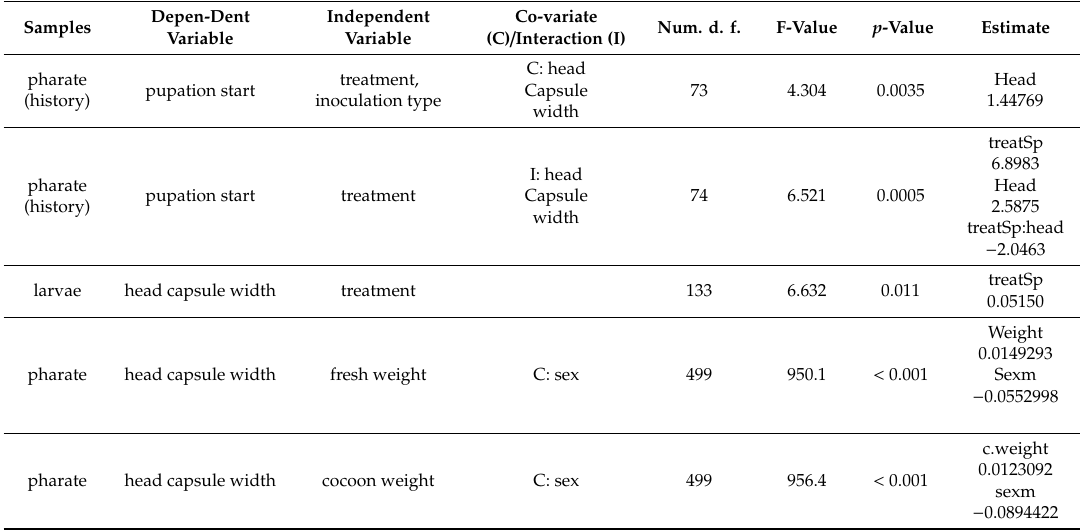
Table A5. Results of a linear multi factorial model exploring the e ff ect of treatment (Viable vs Sterile spores) on the pupation start, head capsule width and weight di ff erences during development and results of regressions of the three datasets for two development stages. Head capsule width, bee age or sex were used as covariates (C). lm = lineaer model, Estimate abbreviations: c.weight = cocoon weight, head = head capsule width, m = male Sp =